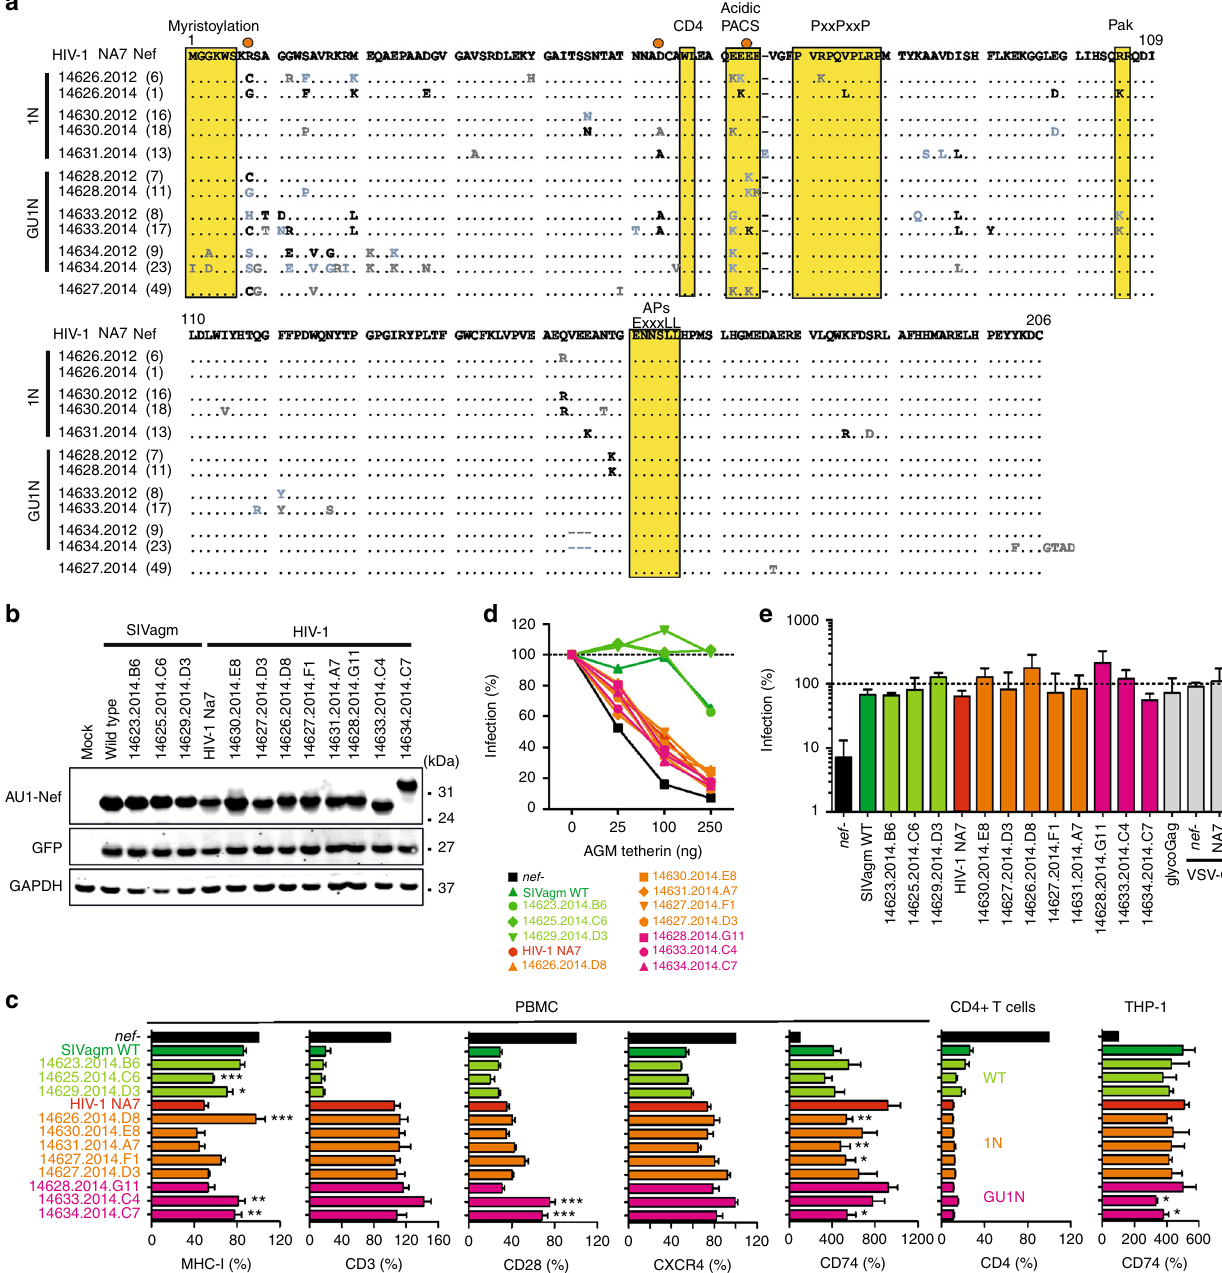
Fig. 5 Maintenance of HIV-1 Nef function in 1N and GU1N infected AGMs. a Alignment of Nef sequences derived from 1N (upper three) and GU1N (lower three) infected AGMs. The HIV-1 NA7 sequence is shown on top and dashes indicate gaps introduced to optimize the alignment. Numbers in parentheses indicate the total number of nef alleles analyzed per time point. Black indicates changes in all, blue in ≥ 50% and gray in at least two sequences. Sites mutated in at least three AGMs are highlighted by orange dots. b Expression of selected SIVagm and HIV-1 Nef proteins. HEK293T cells were transfected with expression plasmids encoding the indicated AU1-tagged Nefs and eGFP. GAPDH and eGFP expression levels were analyzed to control for loading and transfection ef fi ciency, respectively. c Quantitative assessment of Nef-mediated downmodulation of the indicated cellular receptors on PBMCs (MHC-I, CD3, CD28, CXCR4, and CD74), CD4 + T cells (CD4) and THP-1 cells (CD74). Shown are mean ( + SD) fl uorescence intensities (MFIs) of receptor expression relative to the nef -defective control (100%) derived from three experiments. d HIV-1 Nefs did not evolve activity against AGM tetherin. HEK293T cells were cotransfected with HIV-1 NL4-3 nef-vpu- constructs, expression plasmids for the indicated nef alleles and different amounts of